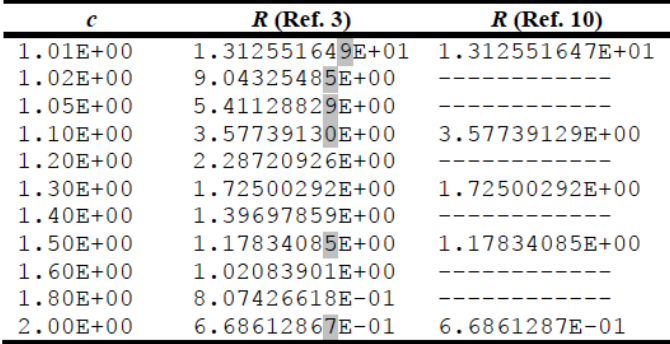
Figure 1. Table 3.4.3(a) from [5] Critical radii comparisons